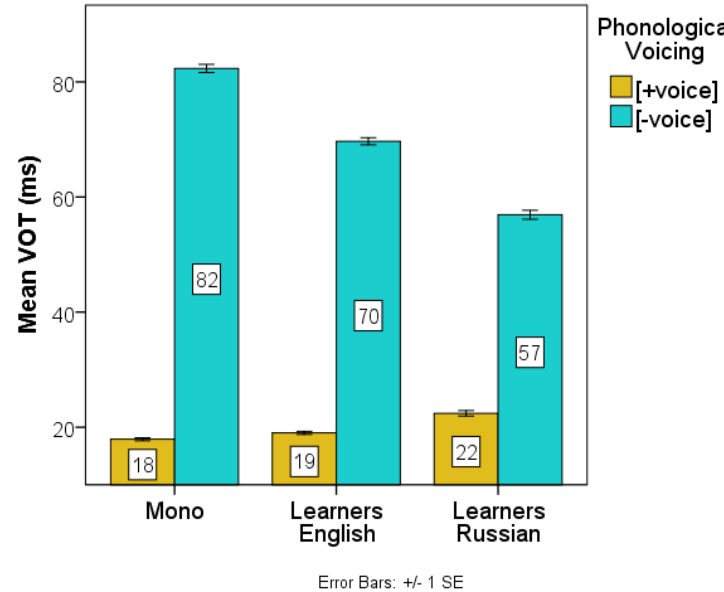
Figure 6. Mean positive VOT of voiced and voiceless initial stops in the English of monolingual controls and learners; learners’ Russian is provided for comparison.